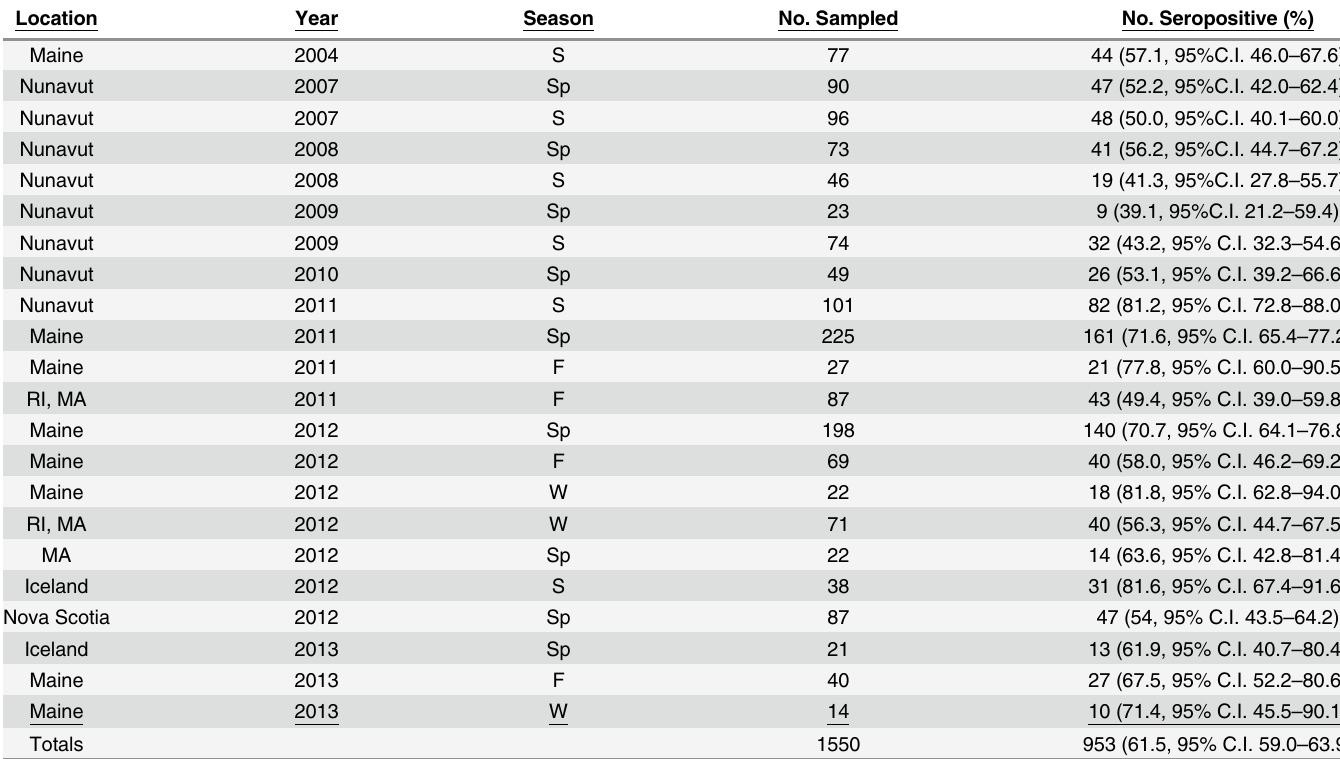
Table 1. Detection of avian influenza antibodies in North Atlantic common